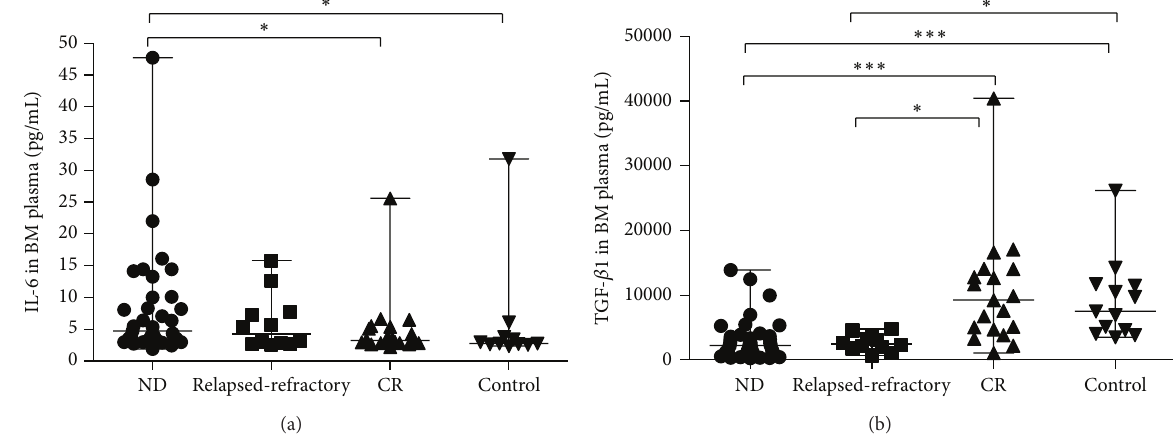
Figure 4: Th17-related cytokines in AML patients and controls. (a) The level of IL-6 was significantly higher in ND AML patients than in CR patients or controls ( ∗ 𝑃 < 0.05 ). (b) A statistical decrease of plasma TGF- 𝛽 1 level in ND or relapsed-refractory AML patients was found compared with CR patients or controls ( ∗ 𝑃 < 0.05 , ∗∗∗ 𝑃 < 0.0001